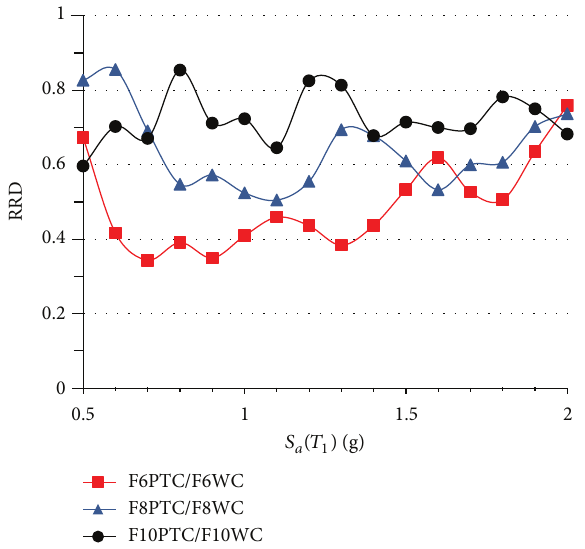
Figure 11: Ratios of mean values of RIDR max for FPTC divided by RIDR max for FWC.